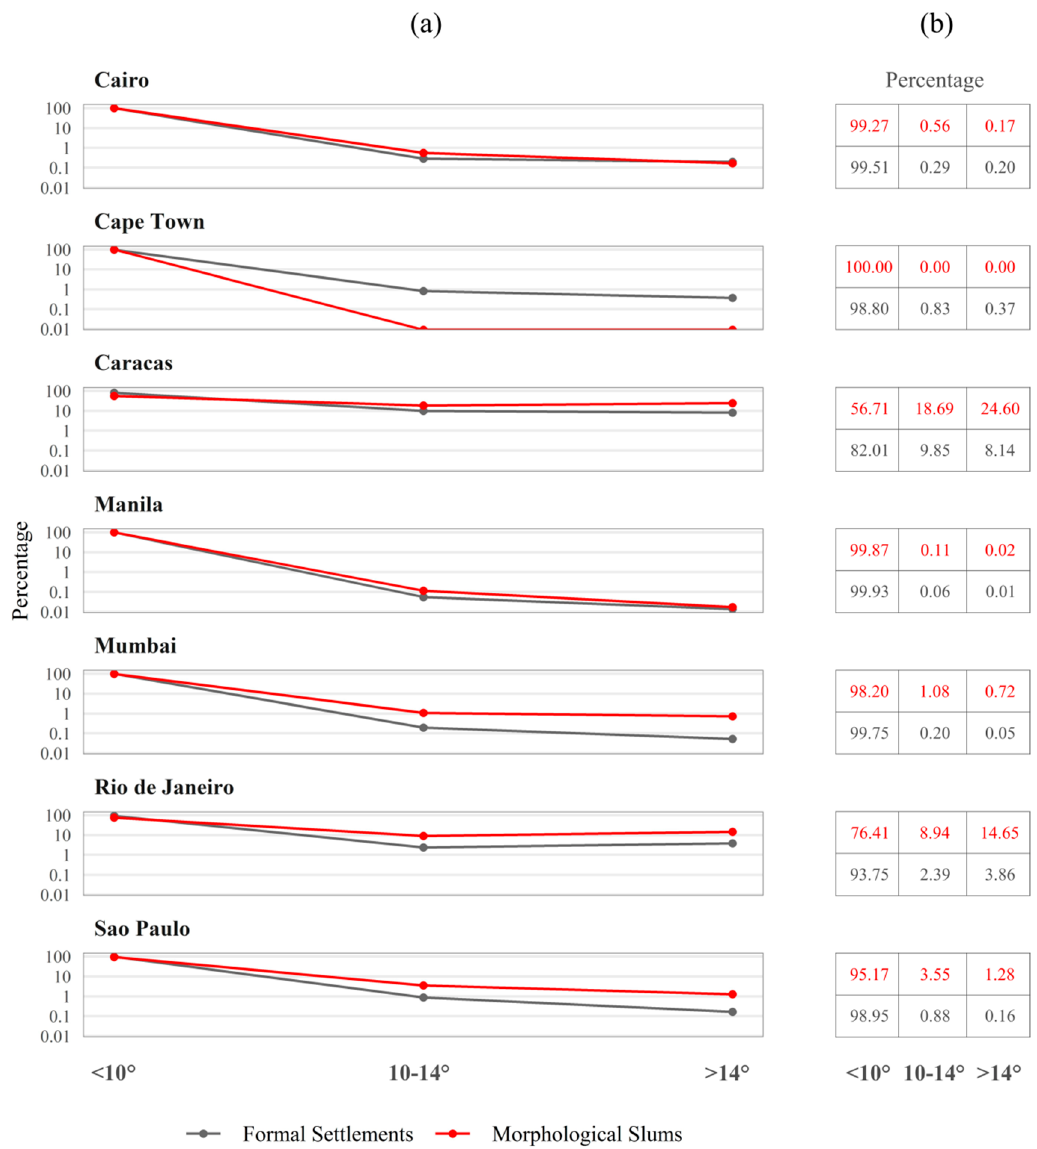
Figure 8. Graphical ( a ) and tabular ( b ) representation of the areal shares (in percentage) per settlement type in slope classes.